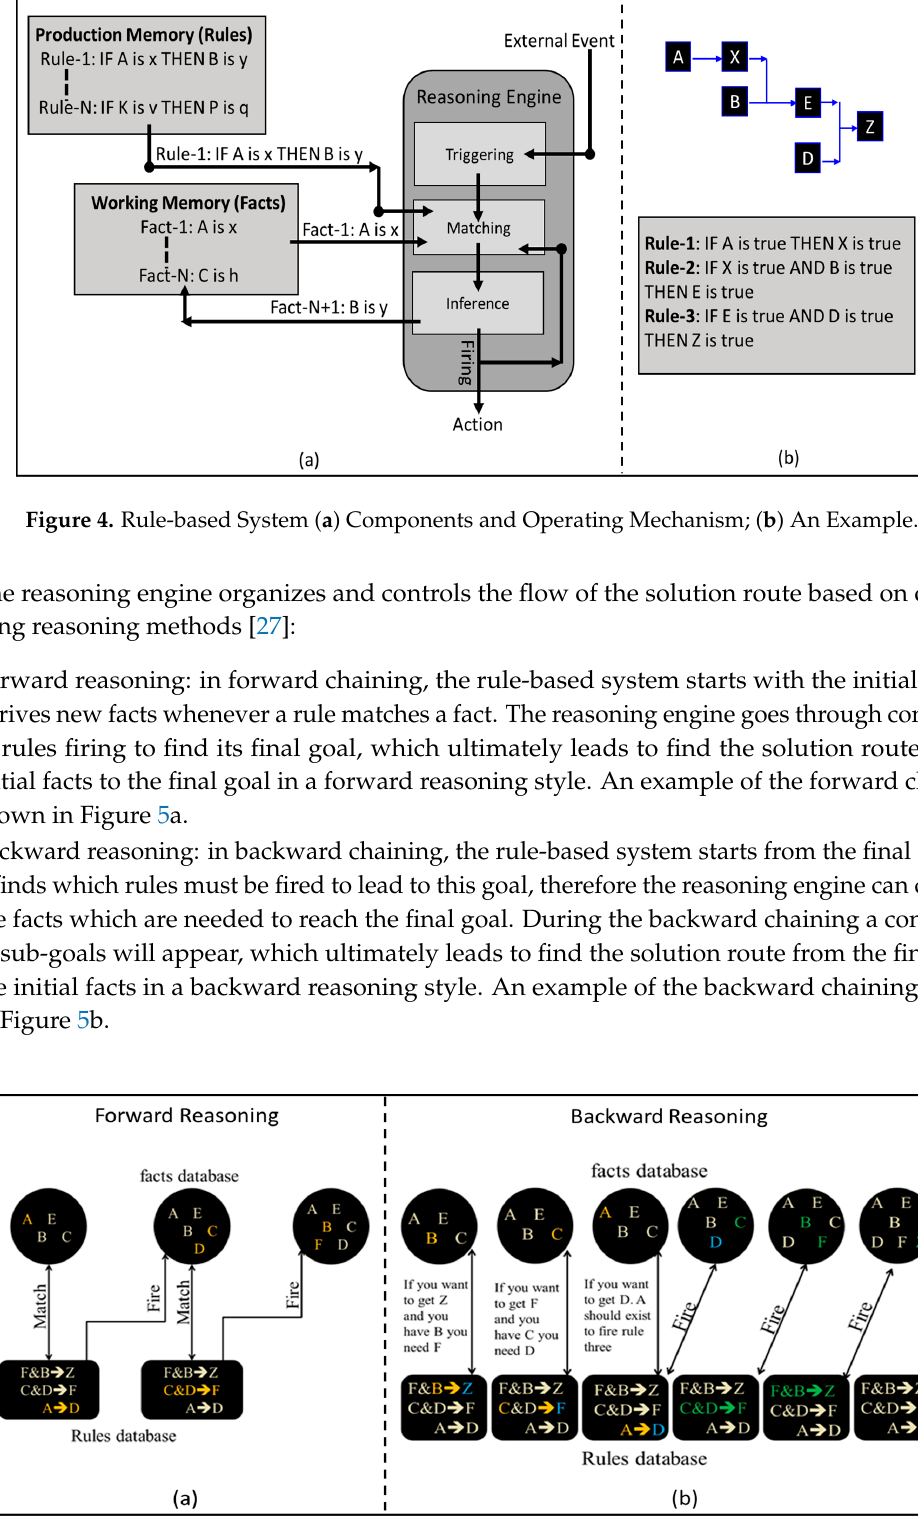
Figure 5. (a) Forward Reasoning—an Example; (b) Backward Reasoning—an Example. Figure 5. ( a ) Forward Reasoning—an Example; ( b ) Backward Reasoning—an